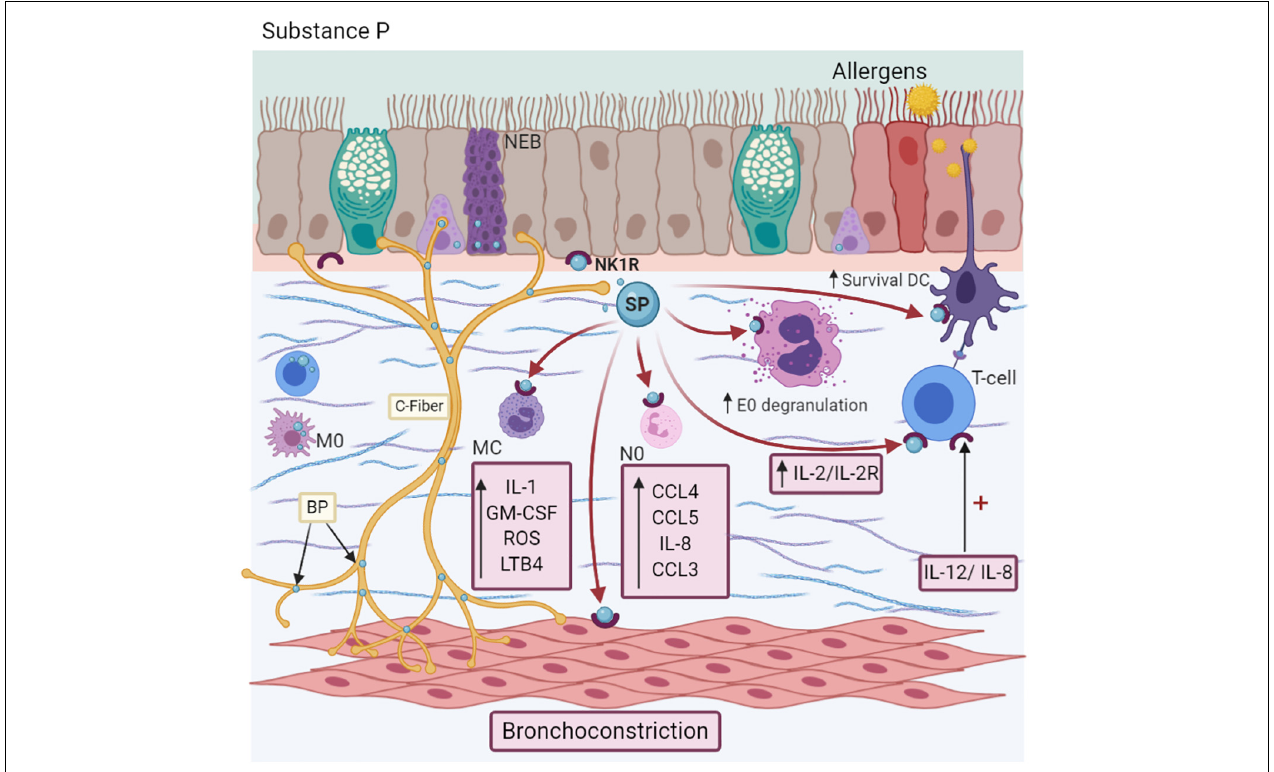
FIGURE 4 | Substance P-SP. C-fibers, NEBs, T cells, and macrophages (M0) synthesize SP. SP induces the synthesis of IL-1, GM-CSF, ROS, and LTB4 synthesis in Mast cells (MC); CCL4, CCL5, IL-8, and CCL3 production in neutrophils (N0); degranulation of eosinophils (E0), dendritic cells (DCs) survival and the promotion of Th2 differentiation. Besides, it causes bronchoconstriction by decreasing SERCA/NCX expression. Its NK1R receptor is localized in many cells and is upregulated in an IL-12/IL-8